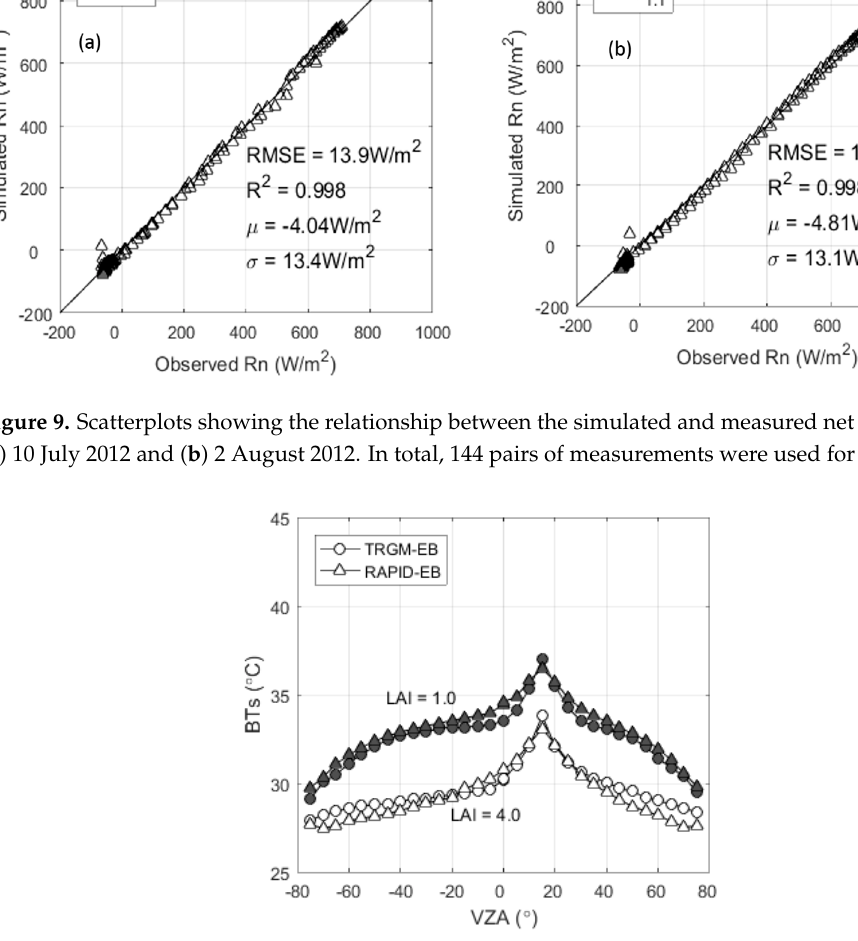
Figure 10. The comparison of BTs simulated by TRGM-EB and RAPID-EB models in the solar principle plane. The black and white points represent scenes with LAI = 1.0 and LAI = 4.0, respectively. The solar zenith angle was assumed to be 15°.